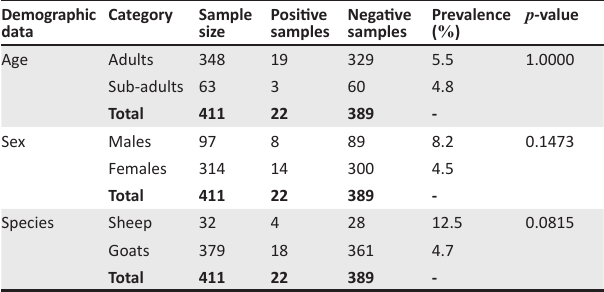
TABLE 2: Univariate Analysis between Seroprevalence of Rift Valley fever virus infections and age, sex and species in Kigoma, Tanzania, May 2011 to June, 2011. Demographic data